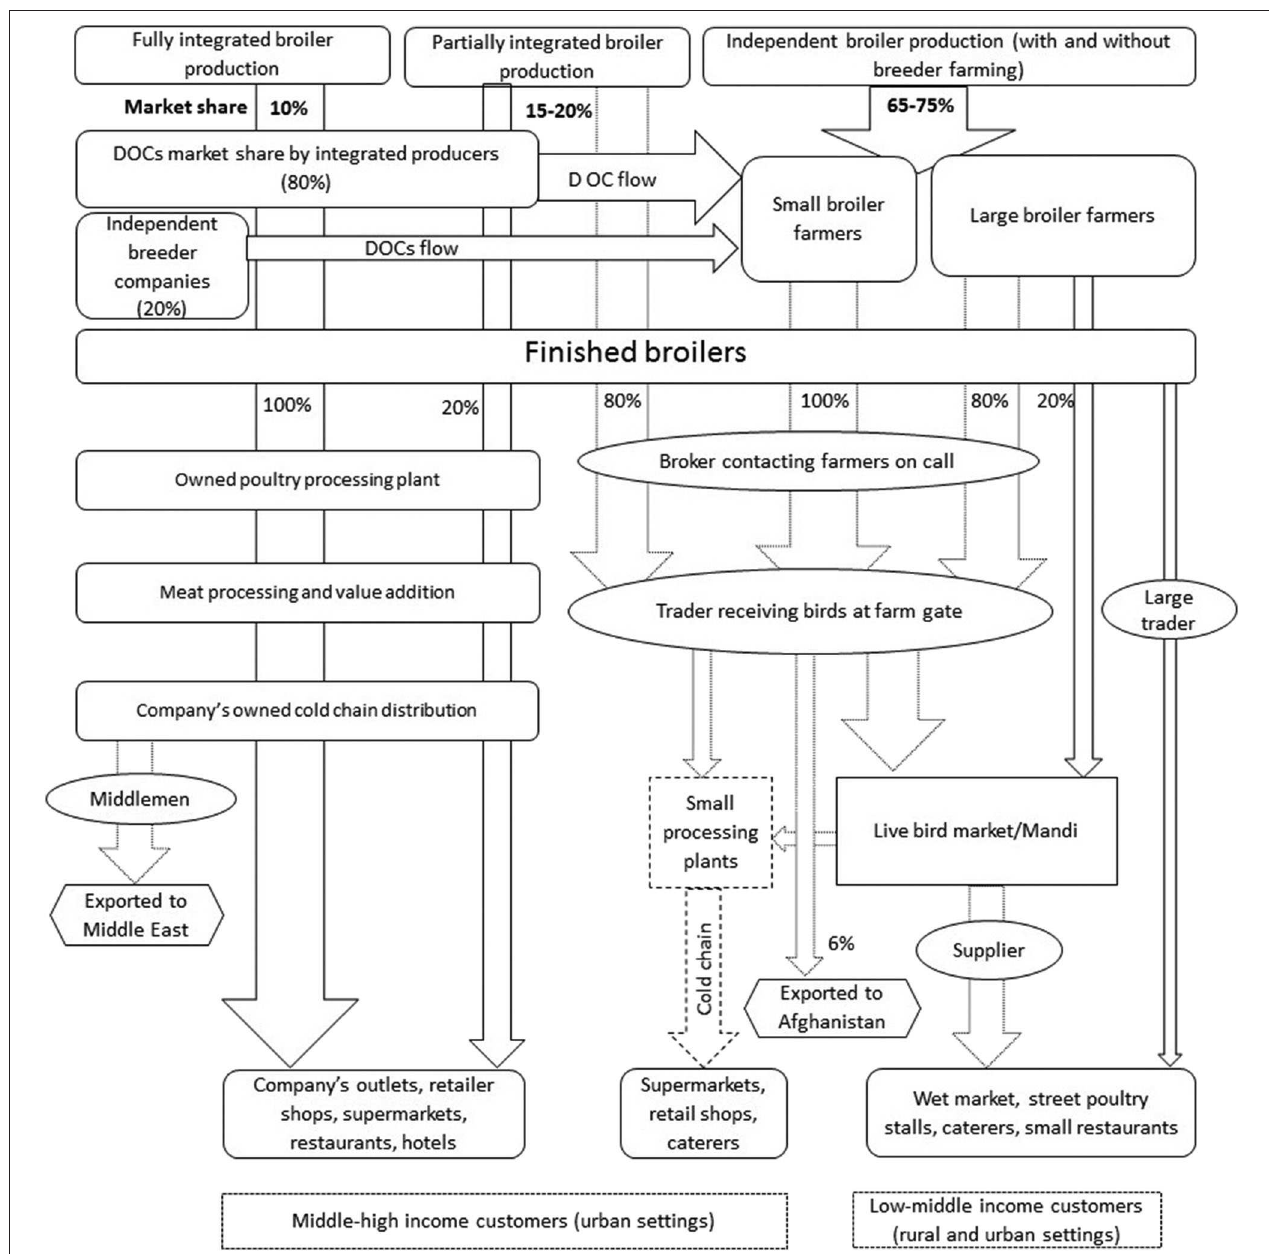
FIGURE 2 | Broiler production systems in Pakistan, their market shares and associated value chains. DOC indicates day old chicks, Mandi in local language Urdu is a wholesale live bird market where birds are sold by open auction. Dotted lines show the parts of chains operated by the middlemen. Numbers in and around arrows and width of arrows indicate the market